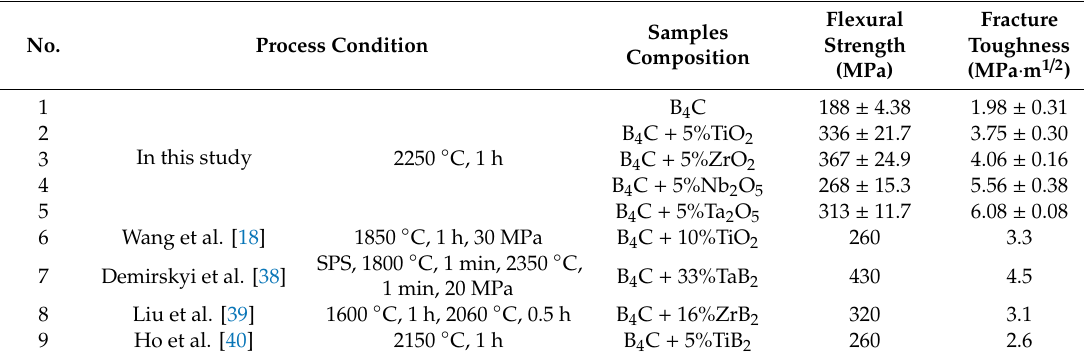
Table 3. Elastic modulus and Vickers hardness values for different samples as compared with the values reported values [35–37].